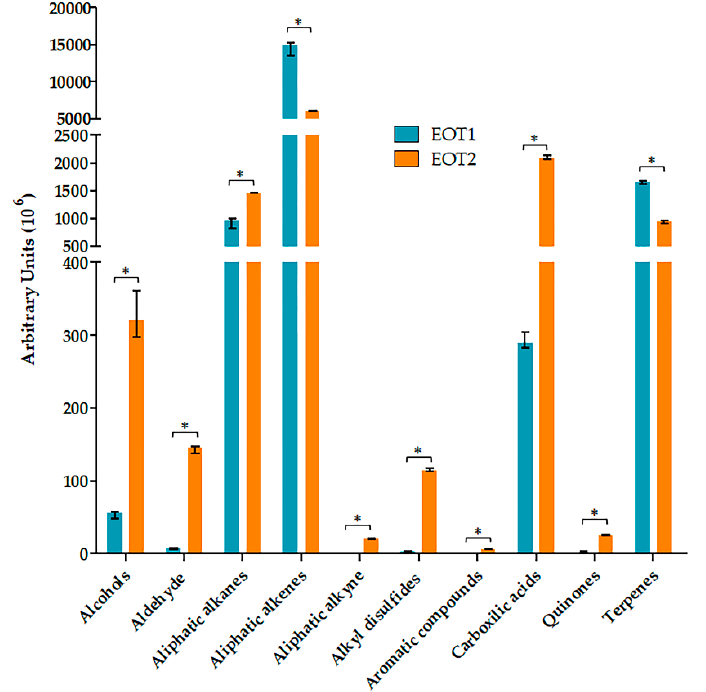
Figure 1. Grouped essential oil compounds. The data are presented as the median of the peak area of each compound (grouped by type) and the range of the data. * Significant difference ( p ≤ 0.05).